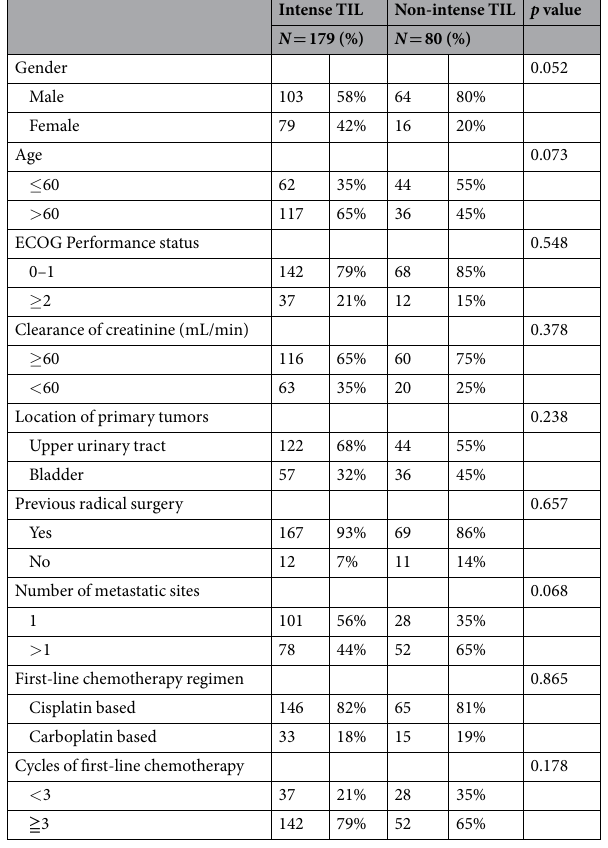
Table 1. Clinical characteristics of 259 patients with metastatic urothelial carcinoma. TIL, tumor infiltrating lymphocyte; UC, urothelial carcinoma; NLR, neutrophil to lymphocyte